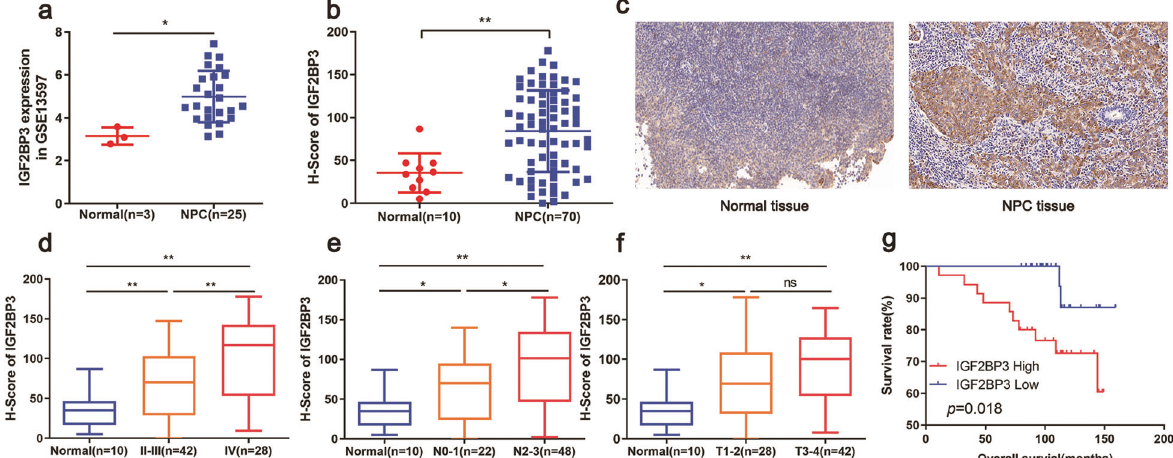
Fig. 1 Identi fi cation of an m6A reader IGF2BP3 whose overexpression is associated with NPC prognosis. a Bioinformation analysis showed the IGF2BP3 expression in normal nasopharyngeal tissues ( n = 3) and the NPC tissues ( n = 25) based on the GEO datasets (GSE13597). b , c The expression level of IGF2BP3 was detected by IHC analysis ( c ) and assessed by H-score ( b ) in normal tissues ( n = 10) and NPC tissues ( n = 70). d – f IGF2BP3 expression was analyzed in normal and NPC patients regarding tumor grade ( d ), N stage ( e ), and T stage ( f ), using